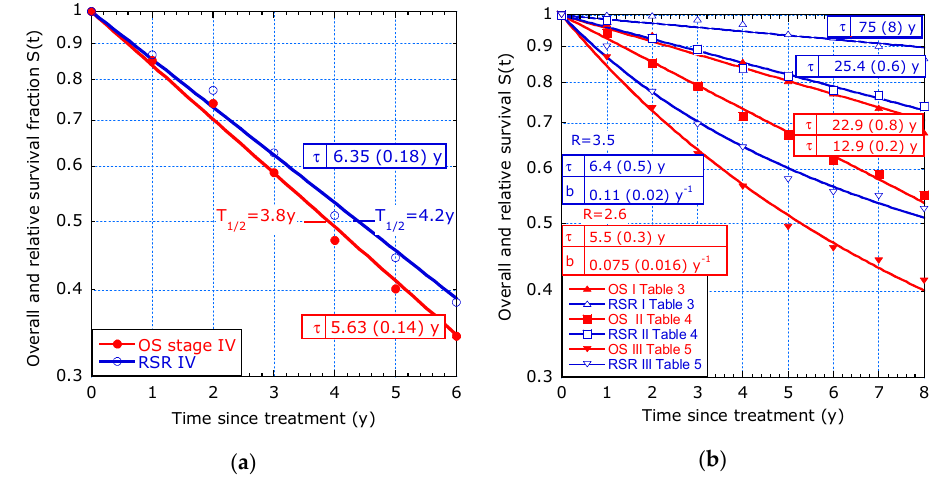
Figure 5. Rectal cancer selected with respect to tumour stage: ( a ) Exponential decay is applied to OS (red) and RSR (blue) for stage IV ([5], Table 6); ( b ) OS and RSR ([5], Tables 3 and 4). Stages I, II fit the exponential decay. The time-dependent lifetime in stage III fits the sliding- τ model.